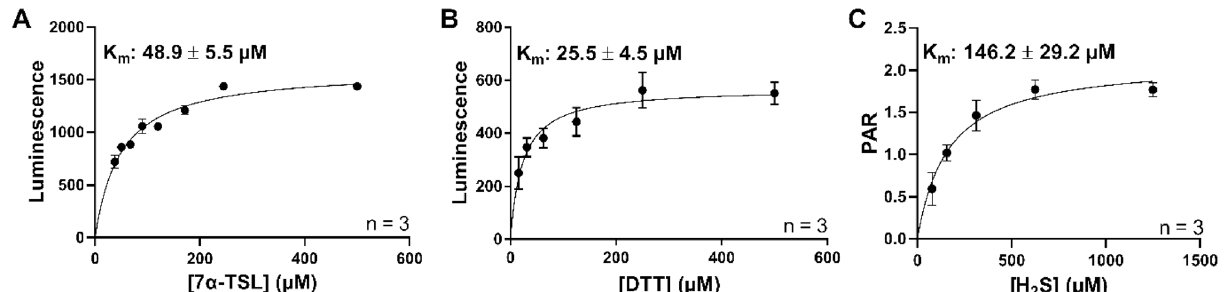
Figure 8. Rate of thiol methylation for His-GST-METTL7B with multiple substrates: ( A ) Luminescence versus concentration curves for 7α-thiospironolactone methylation as measured by AdoHcy formation. ( B ) Luminescence versus concentration curve for dithiothreitol methylation as measured by AdoHcy formation. ( C ) Peak area ratio (PAR) versus concentration curve for hydrogen sulfide methylation as measured by formation of methylsulfide. All data is presented as the mean ±